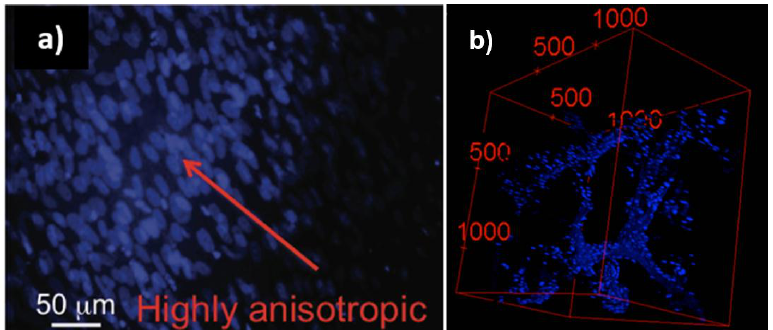
Figure 7. ( a ) Primary human dermal fibroblast (hDF) cultures grown for 5 days on 4LCE-α, grown in film LCE films, reprinted with permission from Reference [103], Copyright 2017 WILEY-VCH Macromolecular Bioscience; and ( b ) fluorescence confocal microscopy images of myoblast cells (C2C12) cultured in LCE foam stained with DAPI (for cell nuclei), 2D images stacked in z direction. Scale units are in μm. Reprinted with permission from Reference [118] Copyright 2016, ACS Macro Letters .